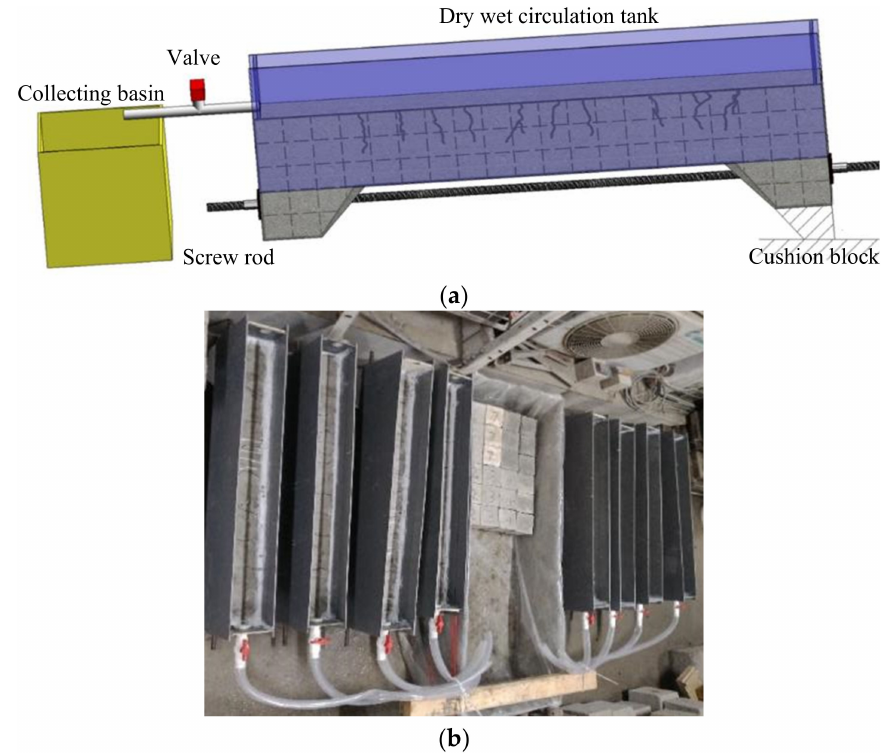
Figure 5. Design ( a ) and photo ( b ) of the